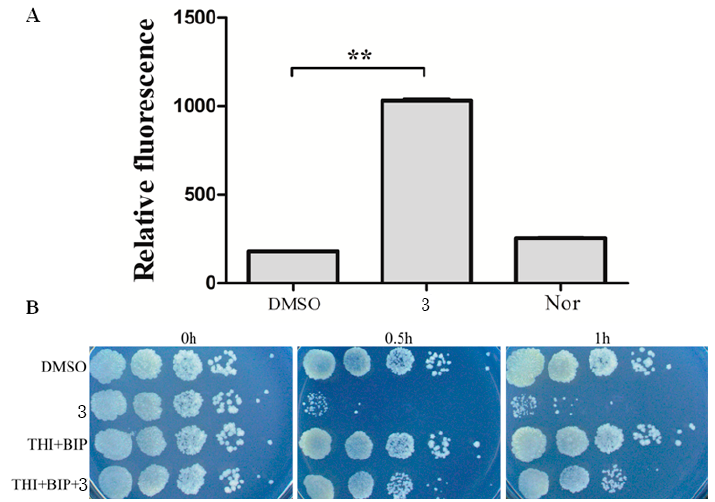
Figure 5. Complex 3 triggers endogenous ROS production in M. smegmatis . ( A ) Percentages of intracellular increase in ROS generation in the presence of 10 times of MIC of 3 . Norfloxacin represents the positive control for ROS production. Data are shown as mean ± SD of triplicate wells. ** p < 0.01; ( B ) Effects of a ferrous chelator and a hydroxyl radical scavenger on 3 lethality. Exponentially growing M. smegmatis cells were preincubated with 250 μ M biphyridyl and 100 mM thioura for 10 min before they were treated with 10 times of MIC of 3 for 0.5 or 1 h. At least three replicate experiments were performed, and each had similar